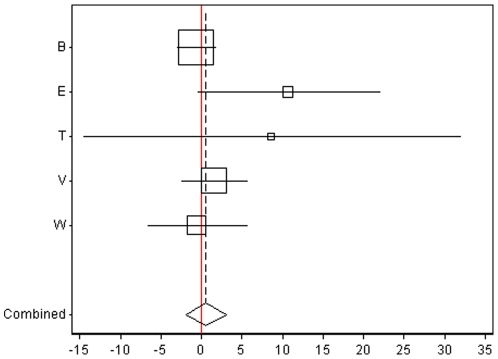
Association (with 95% CI) between a contrast in 10 ug/m3 home outdoor PM2.5 and CIMT progression by trial and the respective meta-analytic estimates.The X-axis indicates the regression coefficient (change) in micrometers. Studies: B  =  BVAIT, E  =  EPAT, T  =  TART, V  =  VEAPS, W  =  WELLHART. The solid line indicates the level of no effect.